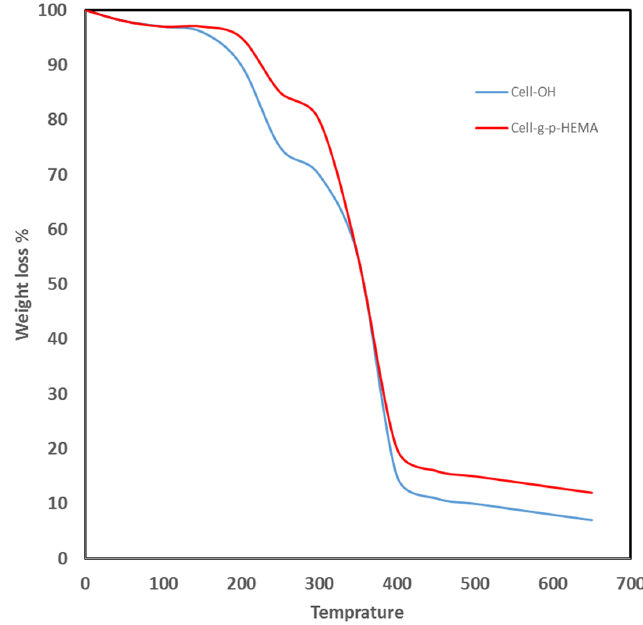
Figure 5. Thermogravimetric analysis of electrospun cellulose nanofiber and electrospun HEMA/CNF copolymer.